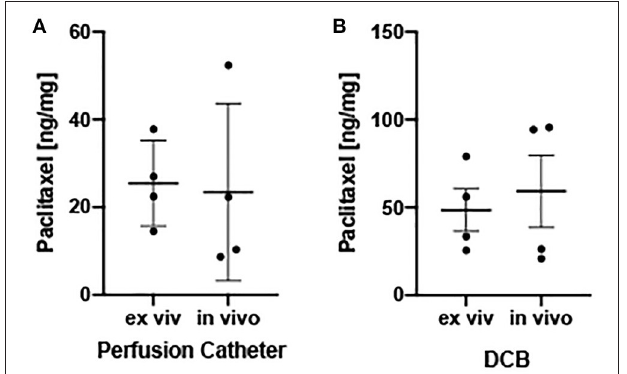
FIGURE 4 | Ex vivo and in vivo arterial drug retention. (A) Scatter plots displaying measured arterial paclitaxel concentrations within the perfusion catheter-treated segments expressed as ng/mg. (B) Scatter plots displaying measured arterial paclitaxel concentrations within the drug-coated balloon-treated segments expressed as ng/mg. Each bar represents the mean ± standard deviation.